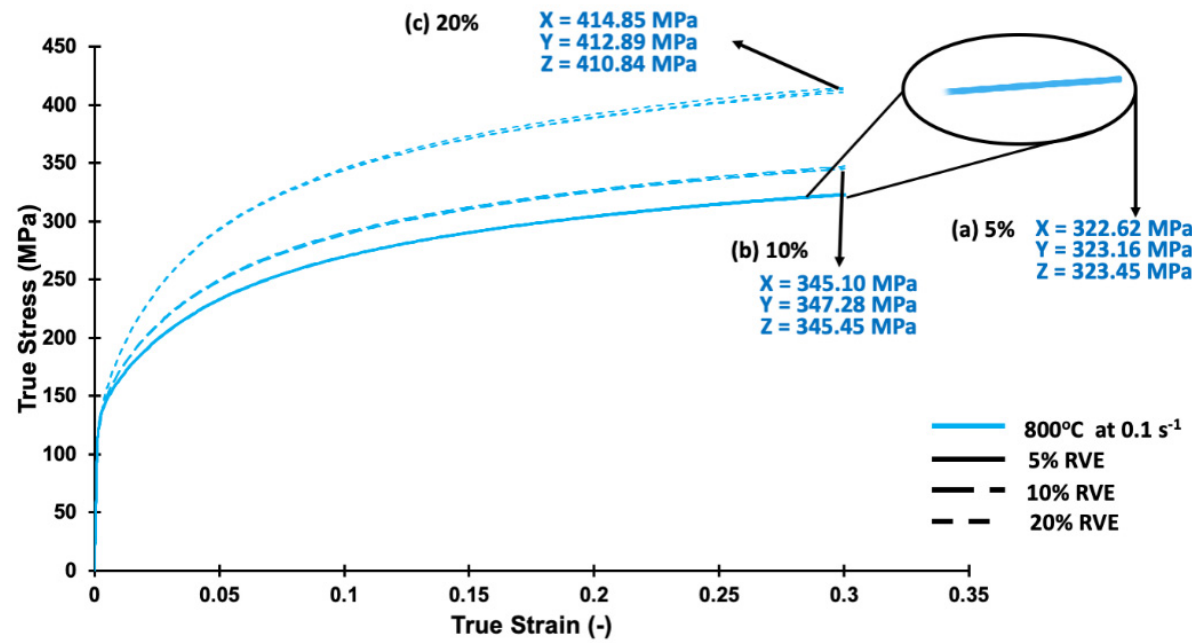
Figure 4. The stress values along the XYZ direction at 800 °C and a strain rate of 0.1 s –1 showed an isotropic behavior in all cases; ( a ) 5% zirconia particles RVE, ( b ) 10% zirconia particles RVE, and ( c ) 20% zirconia particles RVE. The blue lines overlapped with the underlying flow curves. The 2D RVE with a size of 200 × 200 × 1 and 123 grains was built using the